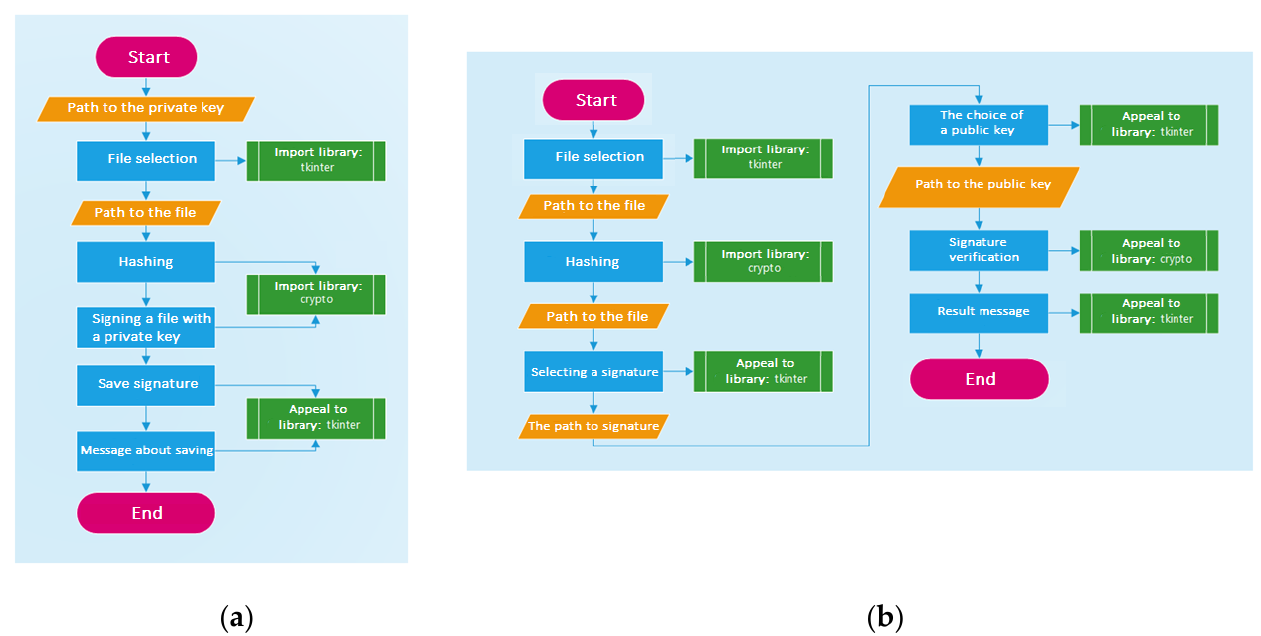
Figure 2. Use of generated keys: ( a ) Signing the file; ( b ) Checking the signature of the file.